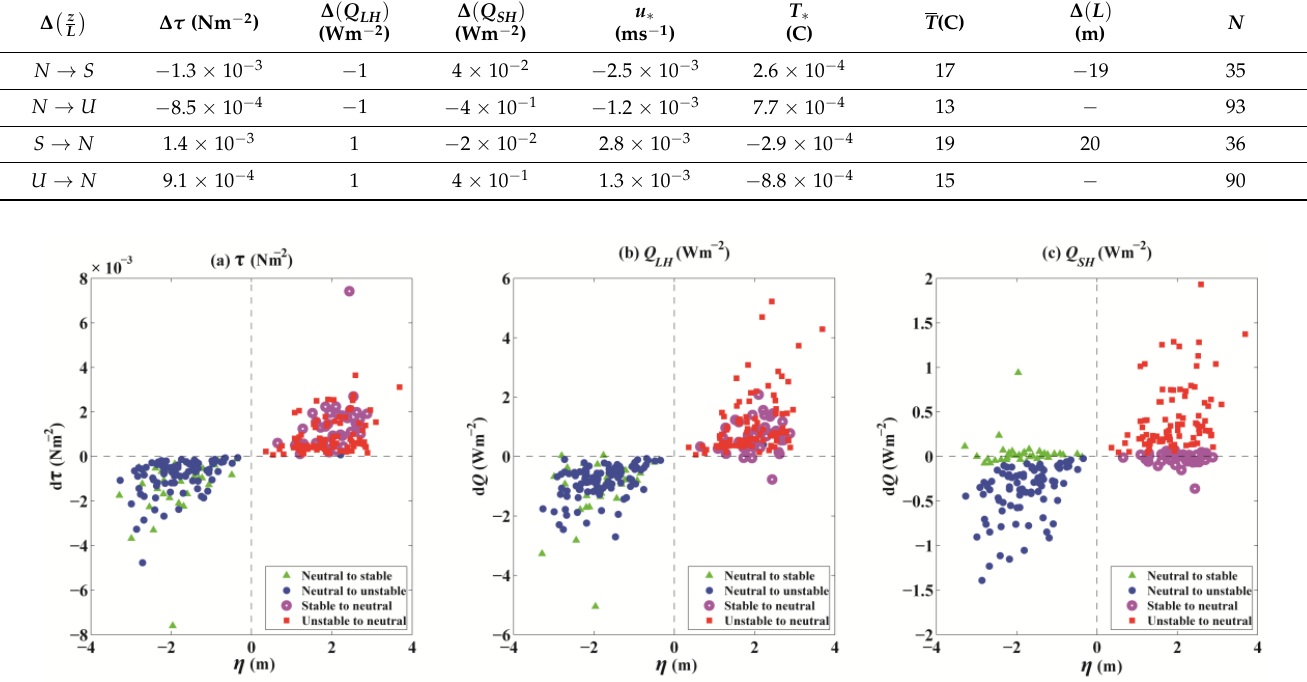
Q (Wm −2 , ( b )), and Q S H L H  , x-axis) along with